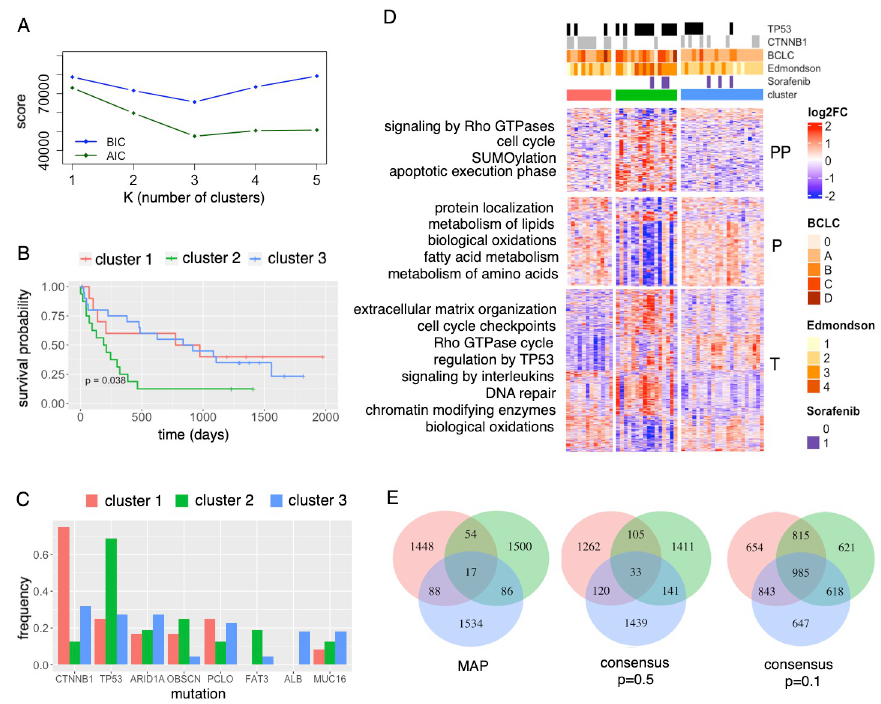
Fig 4. Multi-omics clustering of the HCC dataset with bnClustOmics. (A) BIC and AIC scores of models with different numbers of clusters. (B) Kaplan-Meier survival curves for patients in discovered clusters. (C) Mutational frequencies in discovered clusters. Only mutations with frequency � 15% in at least one of the clusters are shown. (D) Pathway enrichment differences between clusters. (E) Venn diagrams showing the number of common and cluster- specific edges in the discovered MAP and consensus networks learned for cluster 1 (red), cluster 2 (green), cluster 3 (blue); edge directions were